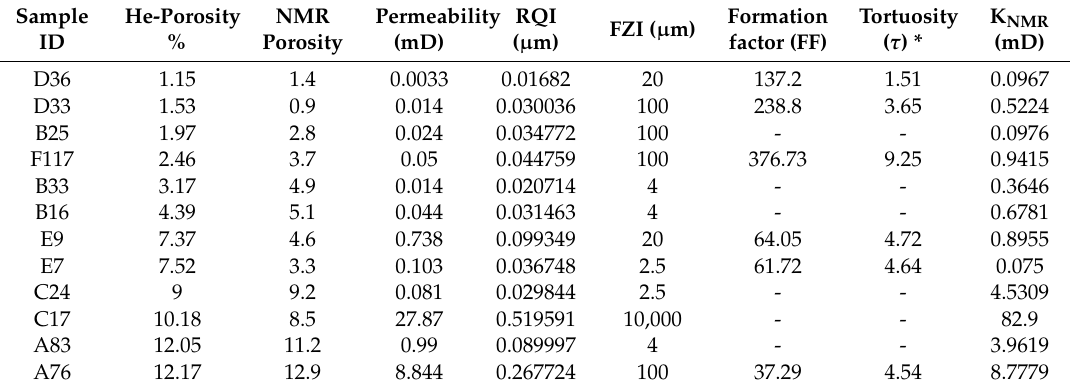
Table 5. Summary of measured petrophysical properties on 12 subsamples representing six wells and the di ff erent hydraulic flow units. FZI: flow zone indicator, RQI: reservoir quality index.